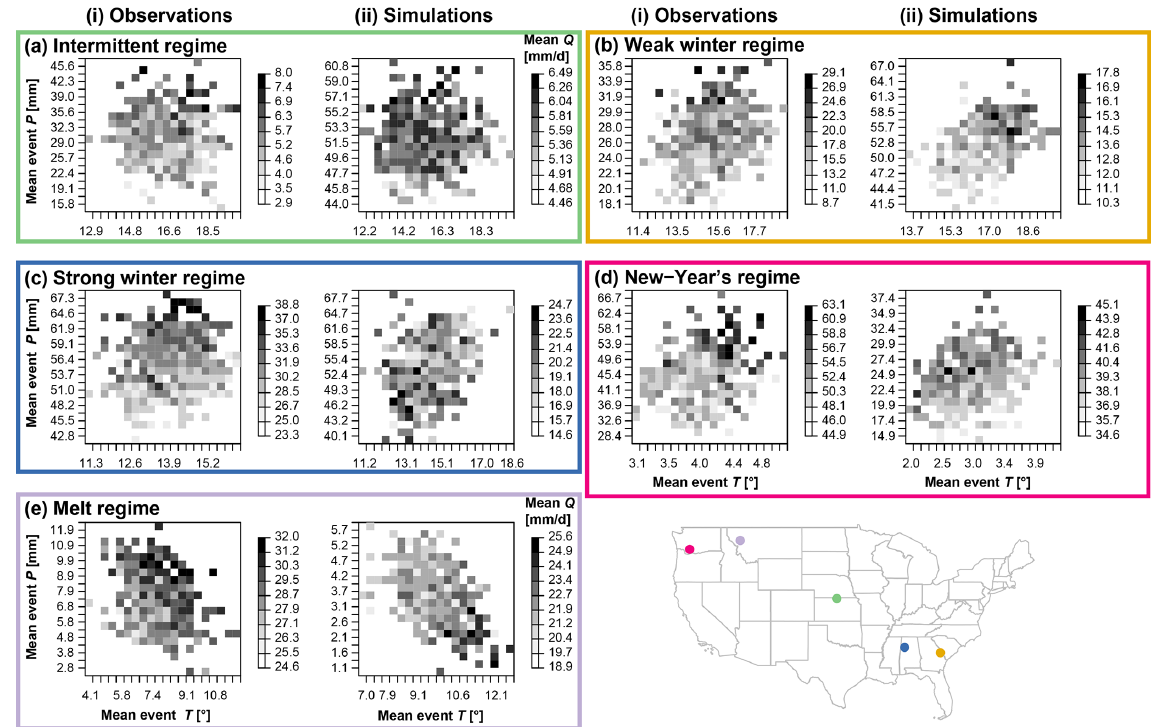
Figure 6. Climate sensitivity analysis for the VIC model: dependence of mean POT magnitude ( Q ) on mean flood event precipitation (1d; P ) and mean flood temperature ( T ) for five example catchments, those with the best E KG per regime type: intermittent regime (green; USGS ID 09210500 Fontanelle Creek near Fontanelle, WY; E KG = 0 . 78), weak winter regime (yellow; USGS ID 02369800 Blackwater River near Bradley, AL; E KG = 0 . 83), strong winter regime (blue; USGS ID 11522500 Salmon River above Somes, CA; E KG = 0 . 84), New Year’s regime (pink; USGS ID 14303200 Tucca Creek near Blaine, OR; E KG = 0 . 9), and melt regime (purple; USGS ID 13011500 Pacific Creek at Moran, WY; E KG = 0 . 92). Grid axes and grey scales differ between plots, where darker colors indicate higher flood